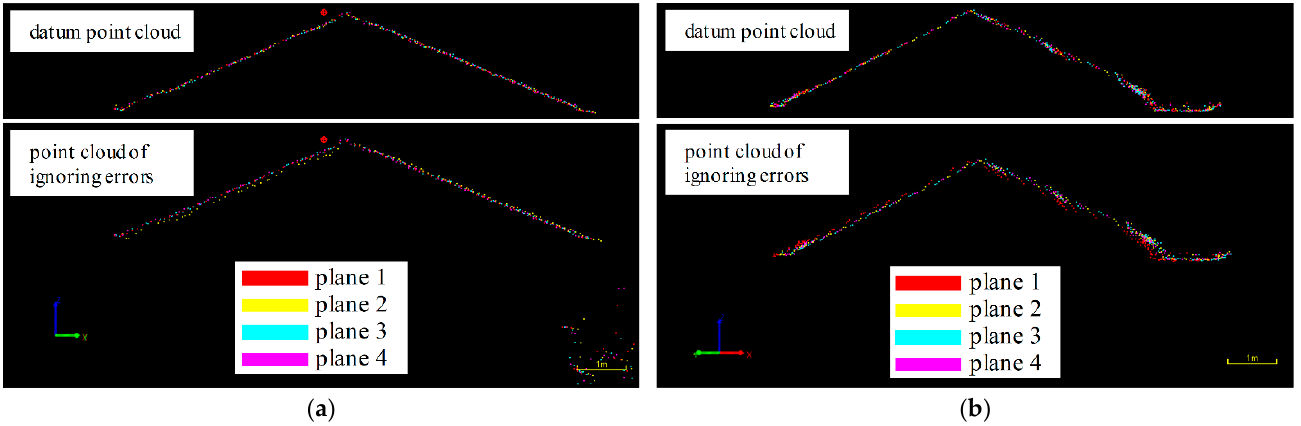
Figure 24. Comparison of point clouds with and without surface error compensation. ( a ) The point cloud comparison of the vertical section of the single flight after setting ∆ θ 2 , ∆ θ 3 , and ∆ θ 4 to 0; ( b ) The point cloud comparison of the parallel section of the single flight after setting ∆ ϕ 1 , ∆ ϕ 2 , ∆ ϕ 3 and ∆ ϕ 4 to 0.